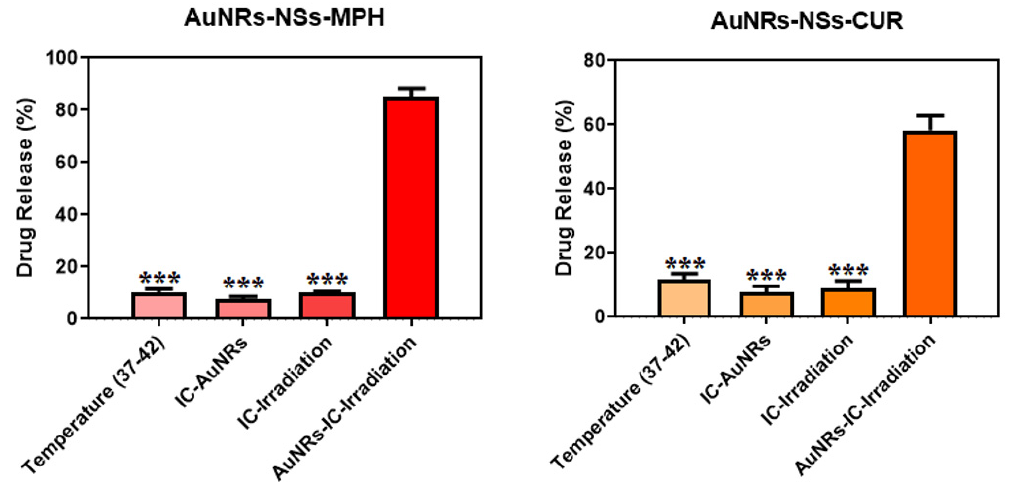
Figure 16. MPH and CUR drug release percentages after 20 min of irradiation. The results are ex- pressed as percentages, compared to the systems used as control, and represent the mean ± SD of n = 3 (*** p < 0.001). n = 3 (*** p <